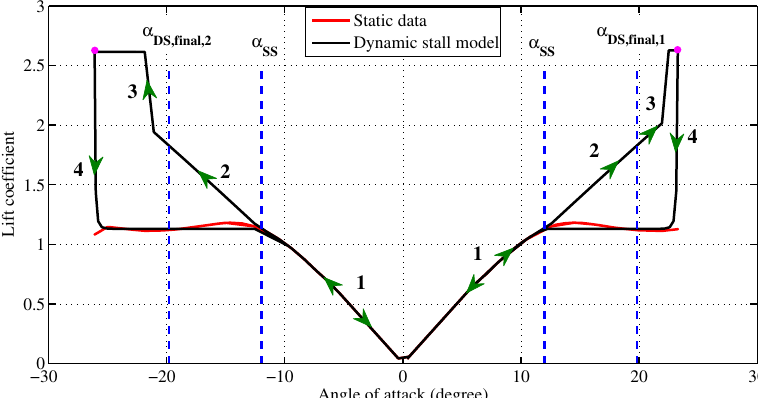
Figure A2. Lift coefficient curve under the dynamic stall model (black line) as compared to the static lift coefficient curve (red line). The four states in the dynamic stall model are indicated in the